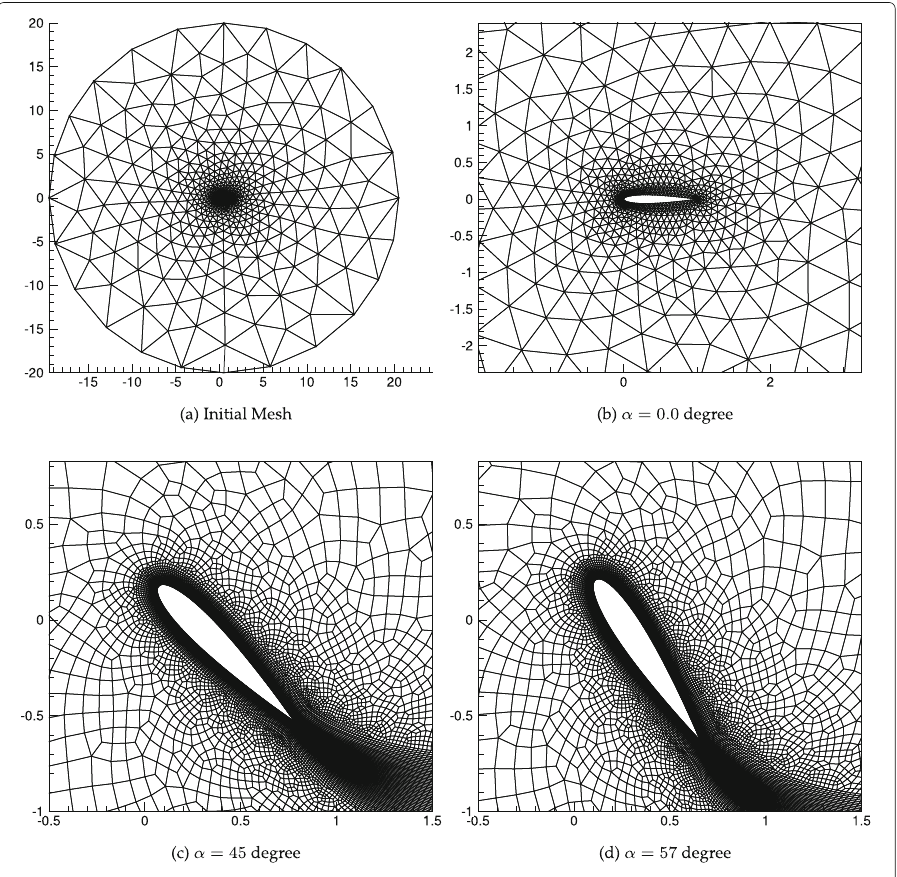
Fig. 12 Initial mesh and mesh at three different angles of attack for the pitching NACA0015